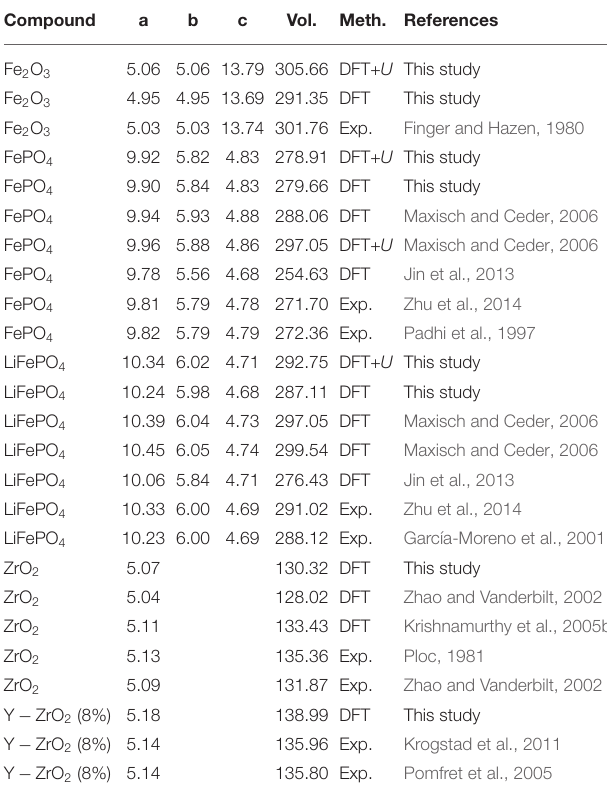
TABLE 1 | The computed Hubbard U parameters for Fe in Fe 2 O 3 , FePO 4 and LiFePO 4 compounds. Compound